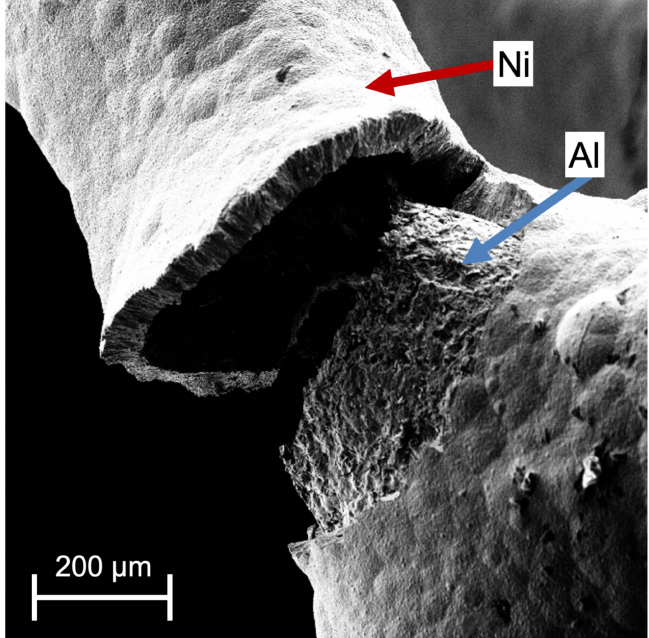
Figure 1. Ni/Al hybrid foam strut after in situ compression of a single pore in SEM, delamination of the Ni coating is clearly